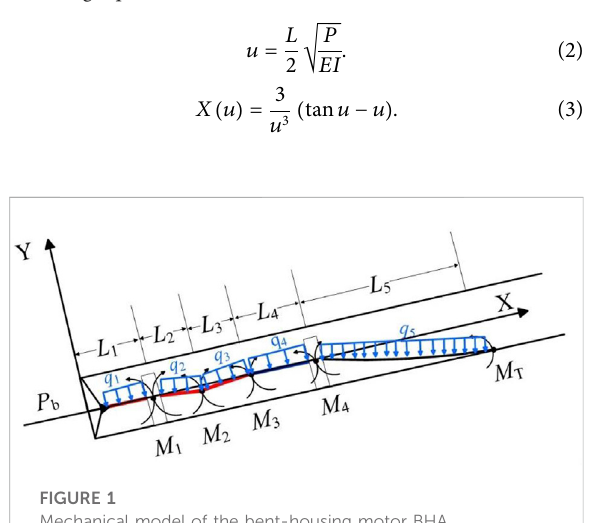
FIGURE 1 Mechanical model of the bent-housing motor